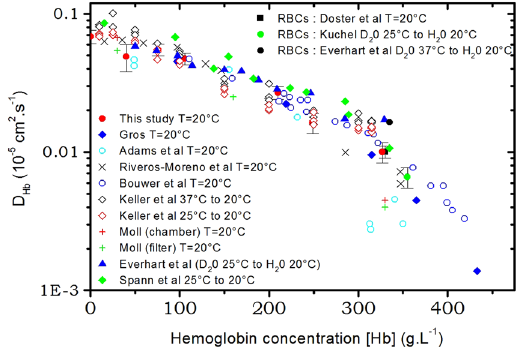
Figure 4. Experimental results of the variation of the self-diffusion coefficient in solution obtained by different methods, big full red circle this study, from Moll 17 green and red crosses 17 , Gross 21 blue diamond, Riveros et al . 20 black cross, Everhart and Johnson 25 blue triangle, Keller et al . T c = 37 °C to T c = 20 °C empty black diamond, T c = 20 °C empty red diamond, Spaan et al . 23 full green diamond, Adams and Fatt 18 full cyan circle and Bouwer et al . 22 empty blue circle. And self-diffusion coefficient measured directly in the RBCs by NMR full black circle 26 , full green circle 27 and NSE in the RBCs full black square 28